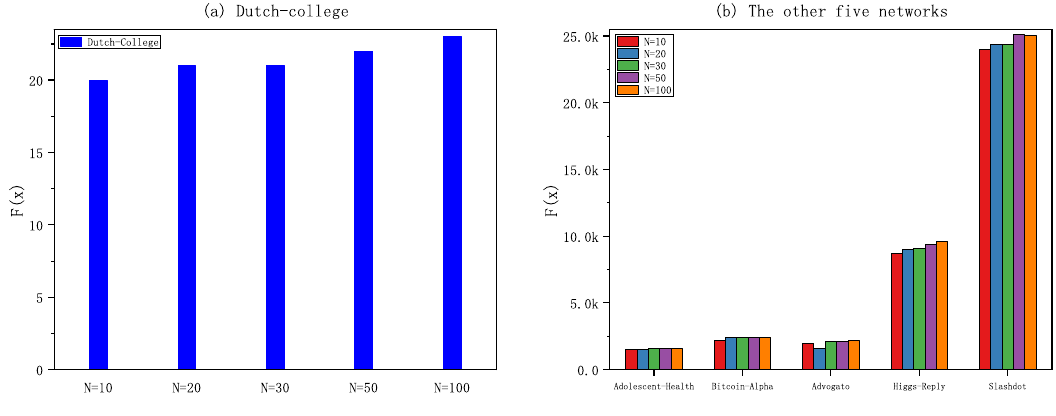
Figure 3. The fitness value of the objective function corresponding to different parameters N on the six